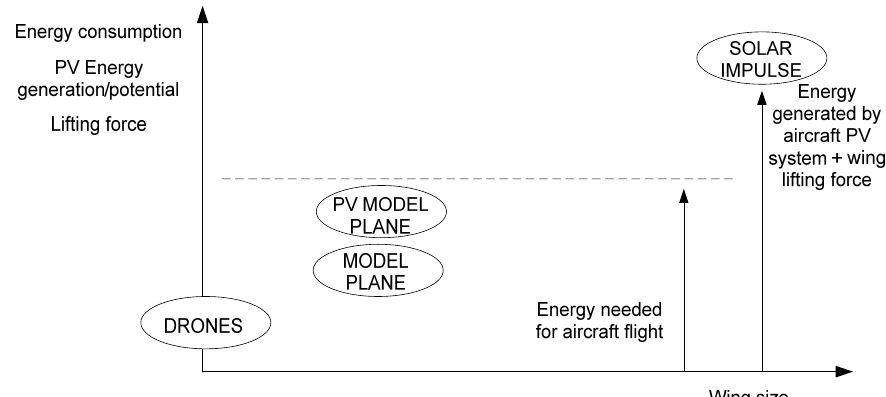
Figure 1. Installation of a photovoltaic (PV) system on a model plane should reduce its power consumption and increase its flight time.